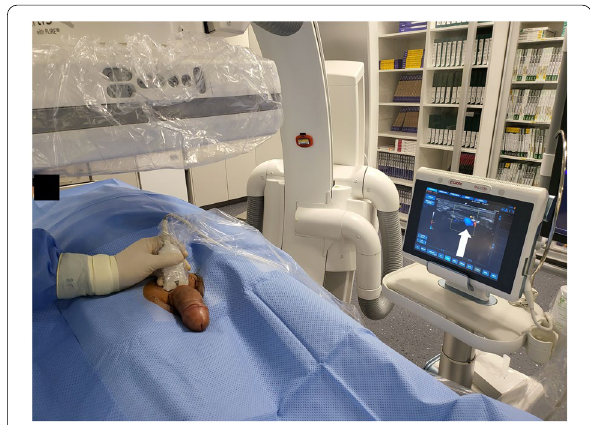
Fig. 1 Angiosuite setup with fluoroscopy and ultrasound. This patient’s penis is sterilely prepped and draped. A 9 MHz ultrasound probe is also sterilely draped and color duplex is used to localize a proximal deep dorsal penile vein (arrow)